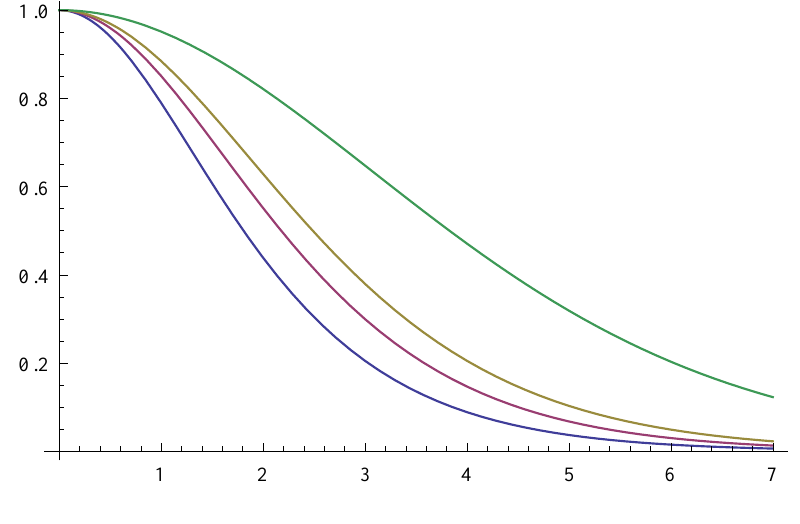
Figure 1. Function ψ n with (from bottom to top) n =